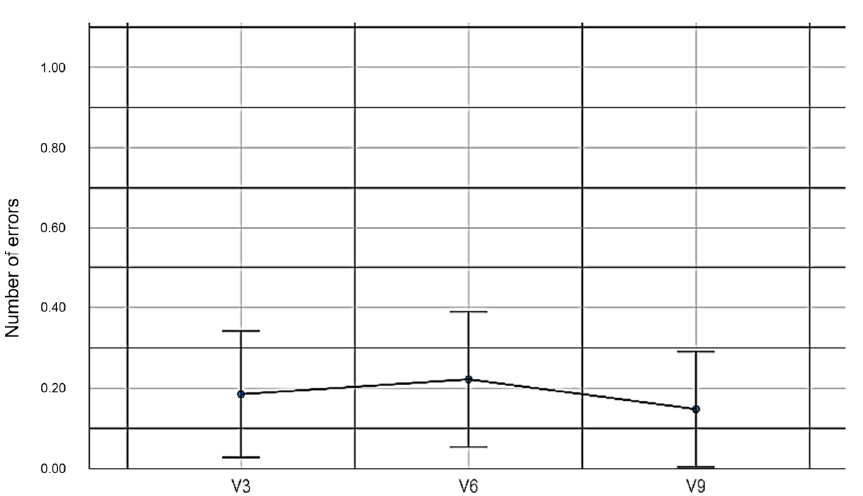
Note: Variables V10 and V12 are described in Section 2.5. Figure 11 graphically indicates the difference in the execution times in the maze ex- periment. Figure 11. Execution times in the maze experiment. When comparing the number of errors made by the participants in the maze experi- ment with the use of the mouse and EMKEY with head movements, statistically signifi- cant differences were found ( t (52,1) = − 2.78, p = 0.004, d = 1.17). These findings do not support our fifth hypothesis. Table 8 shows the values obtained from this measurement.